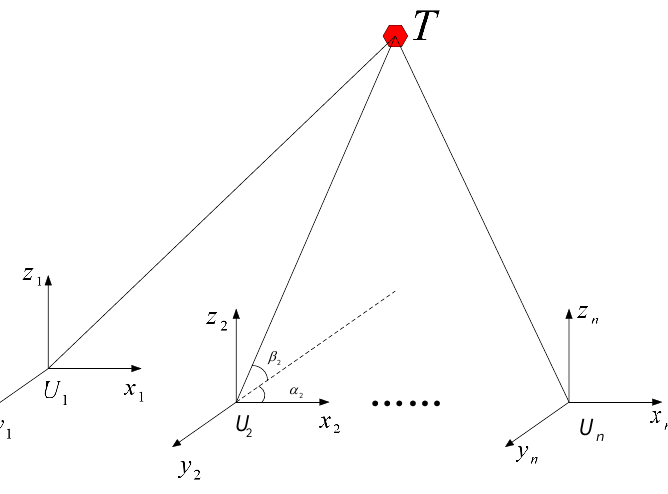
Figure 1. Multi-station AOA positioning.